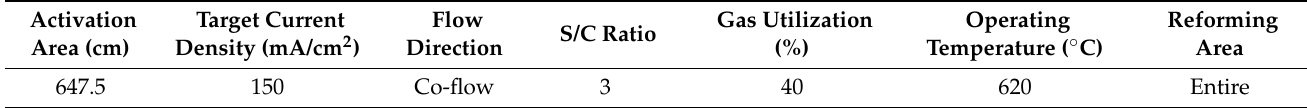
Table 1. Basic operating conditions of MCFCs.